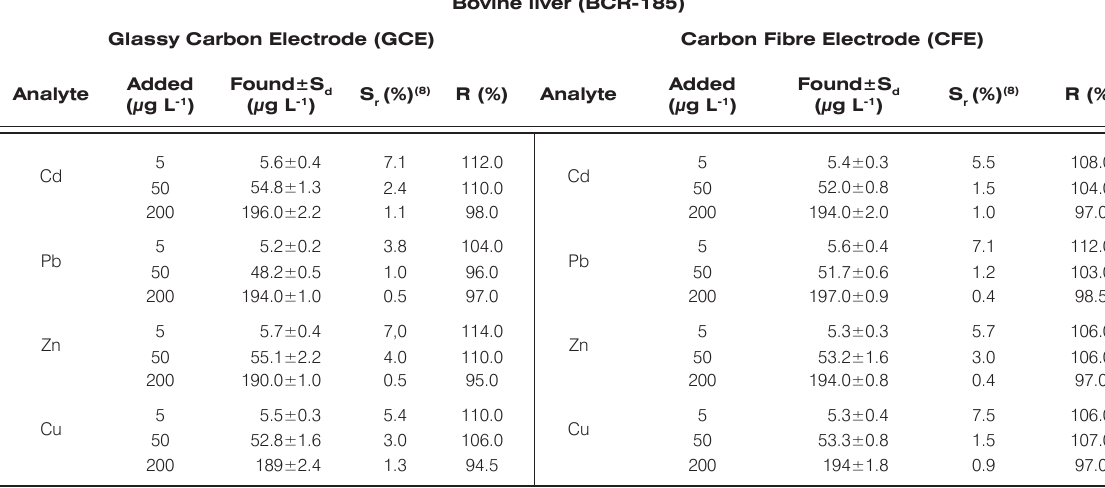
Table 5. Precision and recovery in zinc, cadmium, lead and copper determinations in bovine liver certified reference material (7) Bovine liver (BCR-185) Glassy Carbon Electrode (GCE)